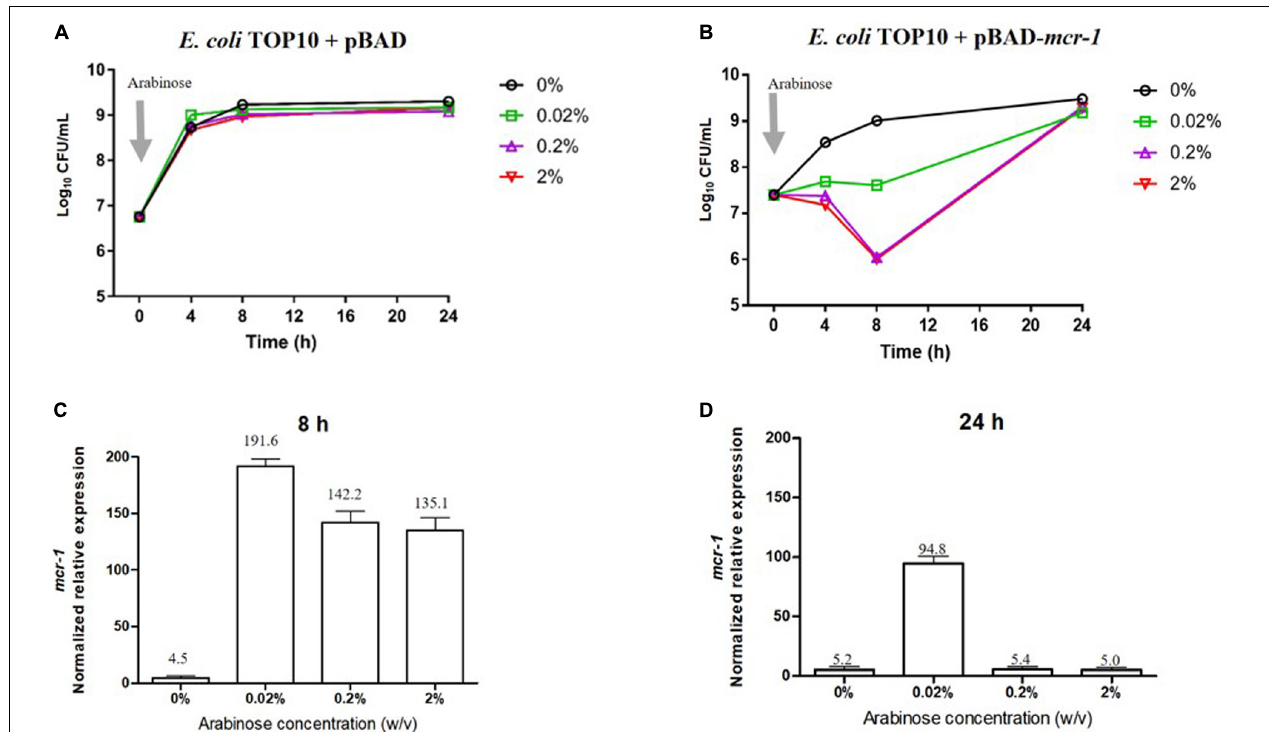
FIGURE 1 | Impact of mcr-1 expression on bacterial growth. Bacterial growth curves of E. coli TOP10 carrying (A) the empty vector pBAD and (B) pBAD- mcr-1 under different levels of Arabinose induction. The expression levels of mcr-1 were measured by qRT-PCR. The normalized relative expression (mean ± SD, n = 3) of mcr-1 in E. coli TOP10 + pBAD- mcr-1 under different levels of Arabinose induction at (C) 8 h and (D) 24